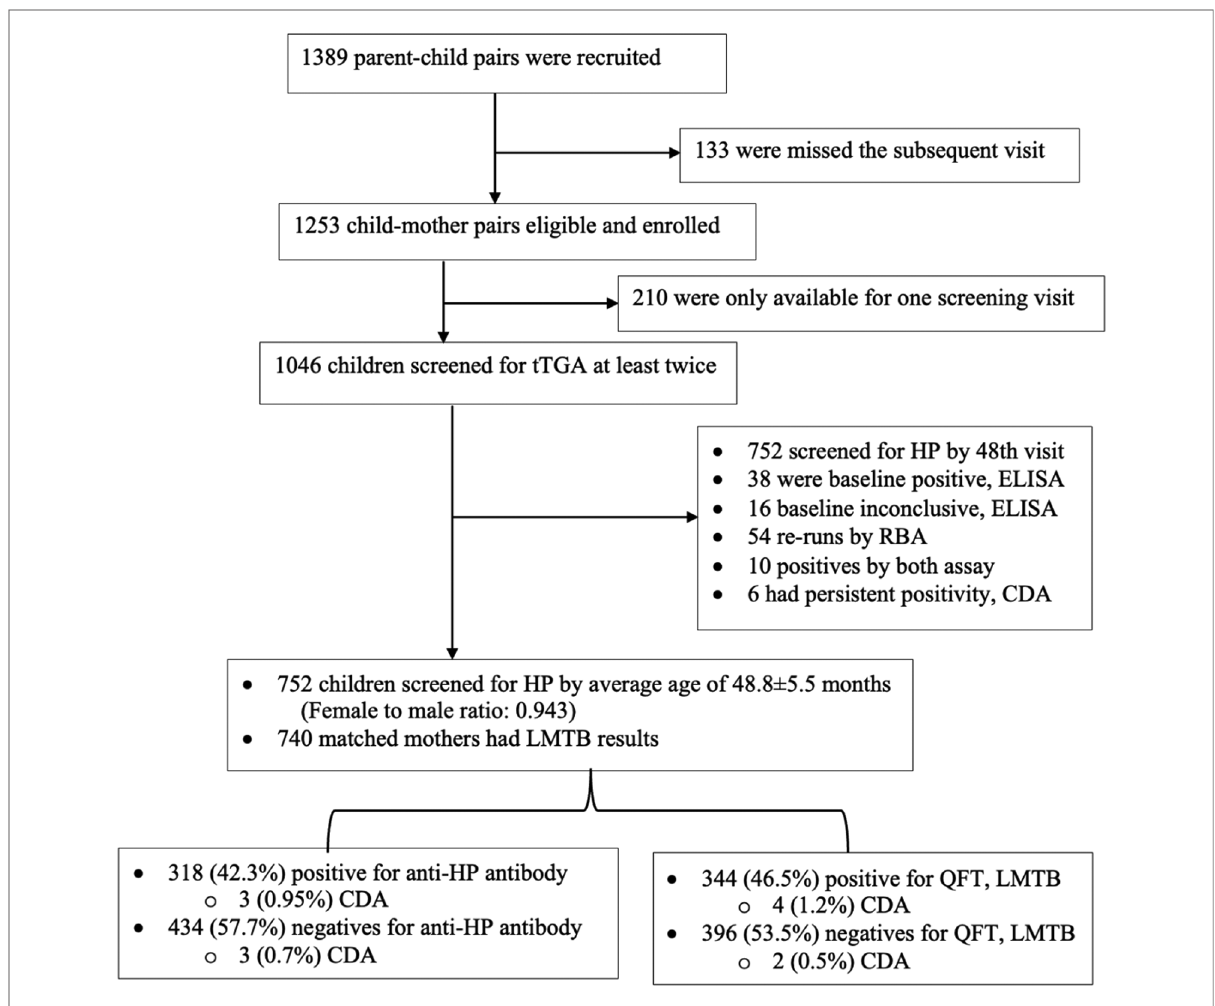
FIGURE 1 Flow chart of study